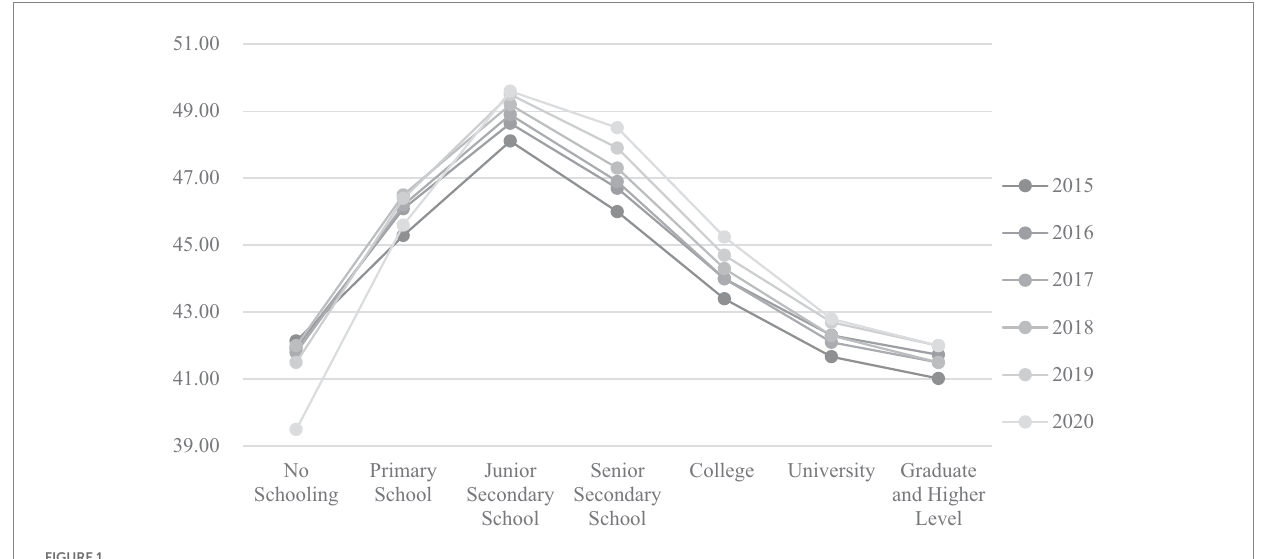
FIGURE 1 Weekly working hours of urban employed persons by educational attainment (hours/per